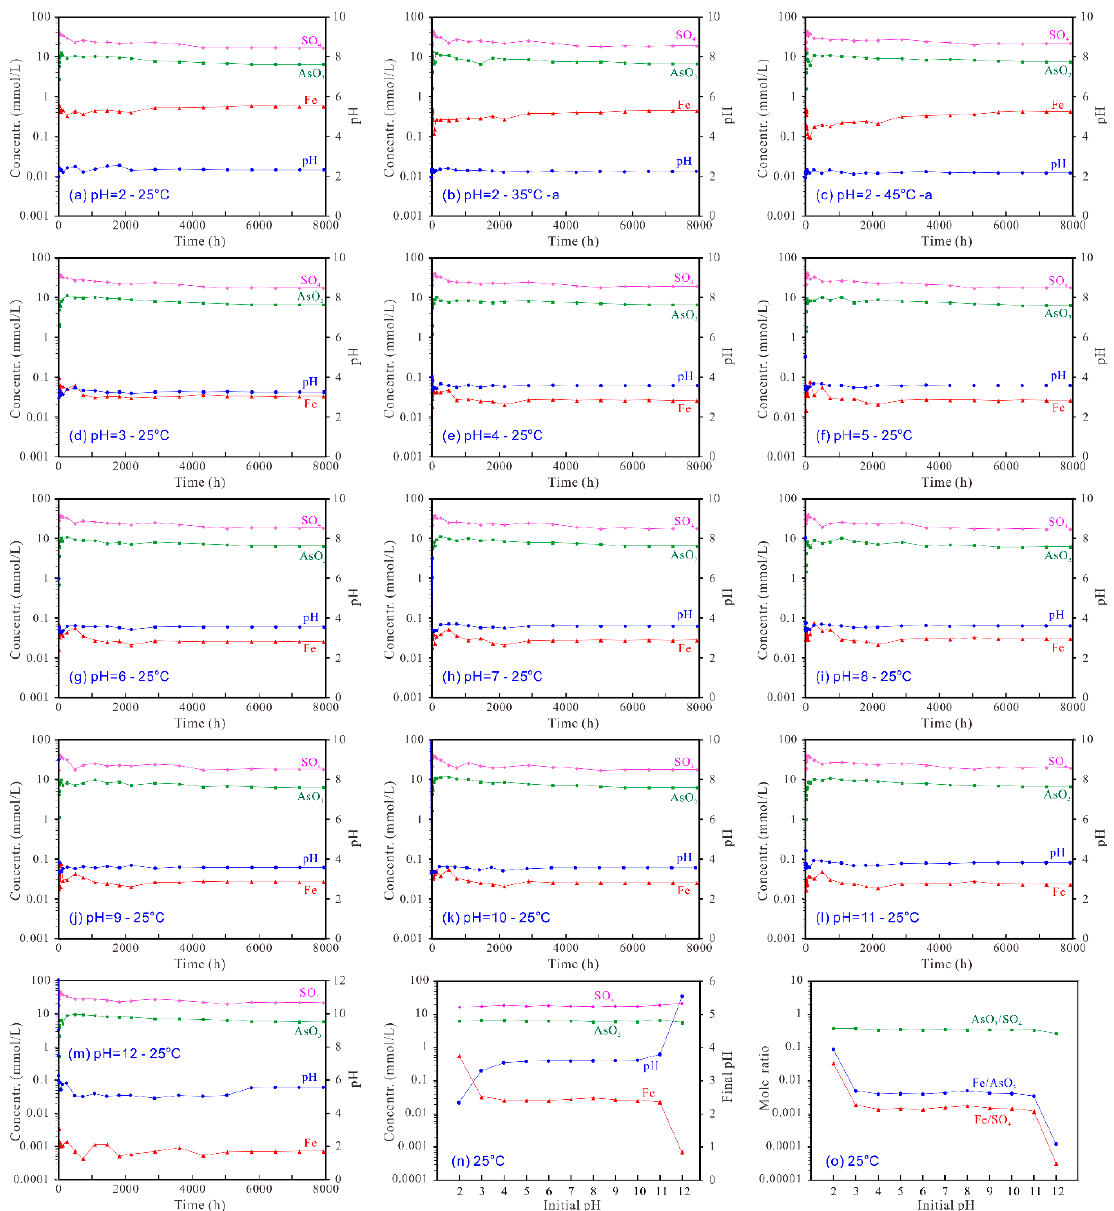
Figure 4. Aqueous evolution during the dissolution of the synthetic tooeleite at 25–45 °C and initial pH 2–12 for 330 d ( a – m ) and the variation of the solution components with initial pH at the end of the experiment ( n , o ).